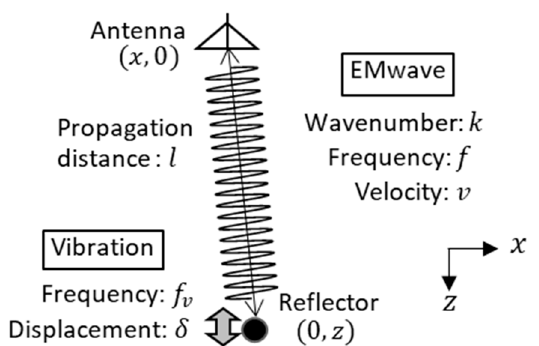
Figure 2. Geometry of problem.